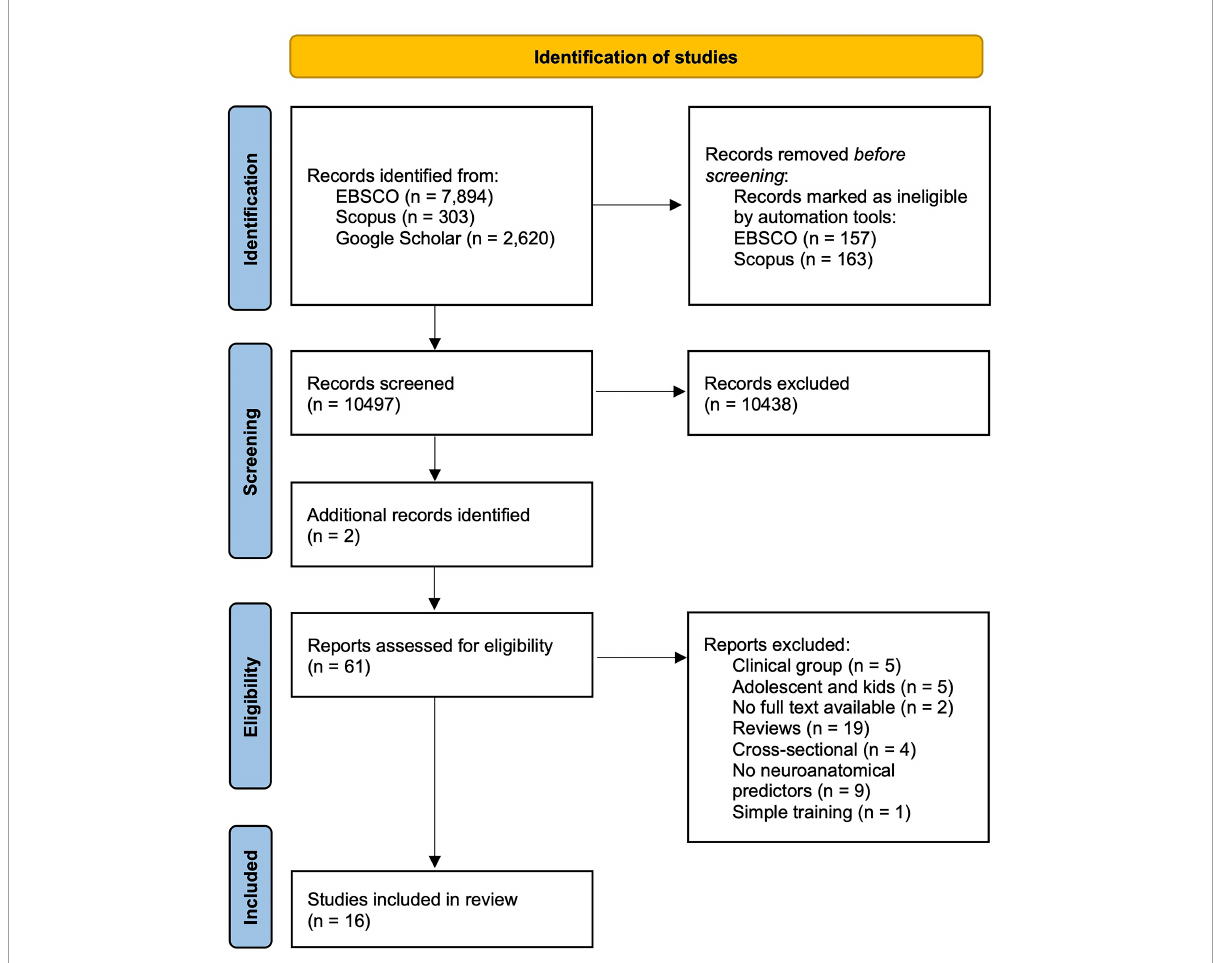
FIGURE2 PRISMA Flow diagram for study selection. Source of template: Haddaway et al.,